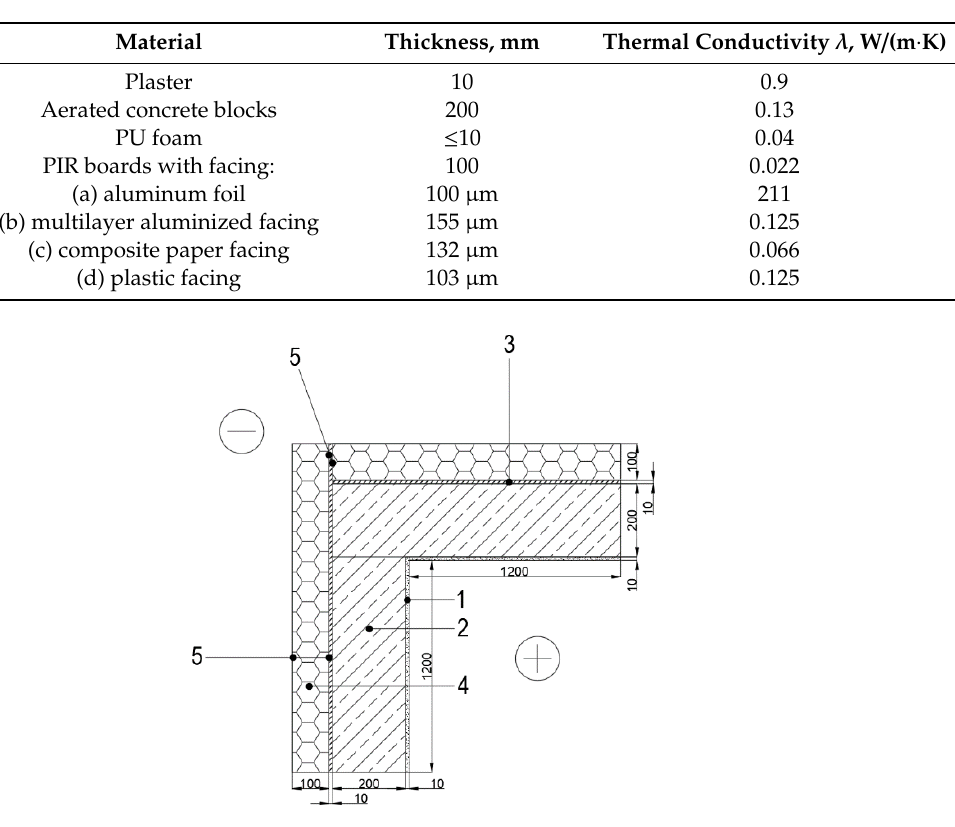
Figure 2. Fragment of the wall corner: 1—plaster, 2—aerated concrete blocks, 3—PU foam, 4—PIR